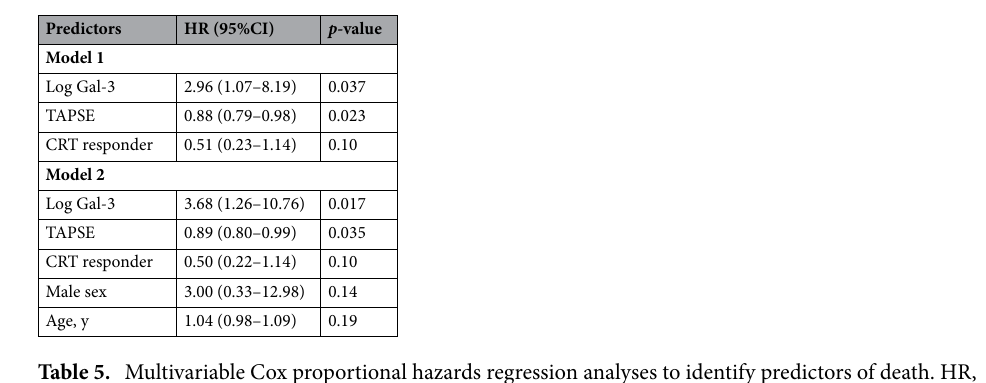
Table 5. Multivariable Cox proportional hazards regression analyses to identify predictors of death. HR, hazard ratio; CI, confidence interval. Gal-3, galectin-3; TAPSE, tricuspid annular plane systolic excursion; CRT, cardiac resynchronization